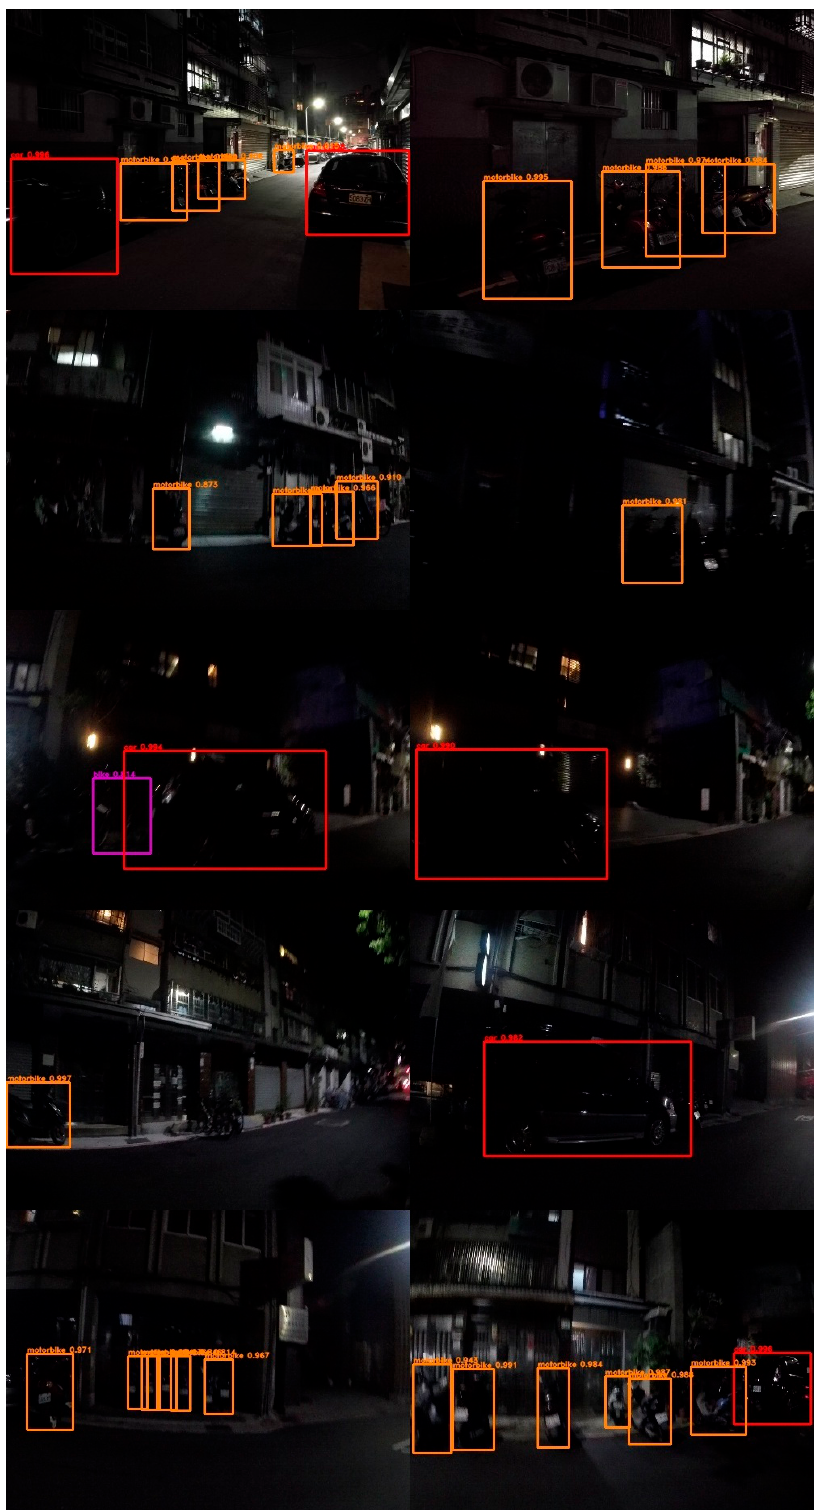
Figure 24. Outputs from the Faster R-CNN [5] with VGG16 [1] in our proposed system trained using our nighttime data.